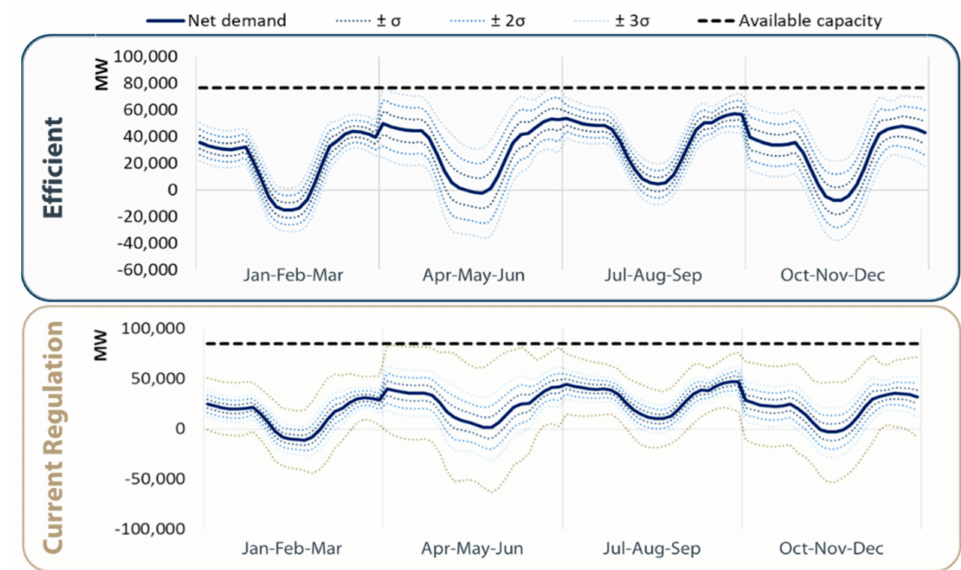
Figure 20. Comparison of the system reliability level between